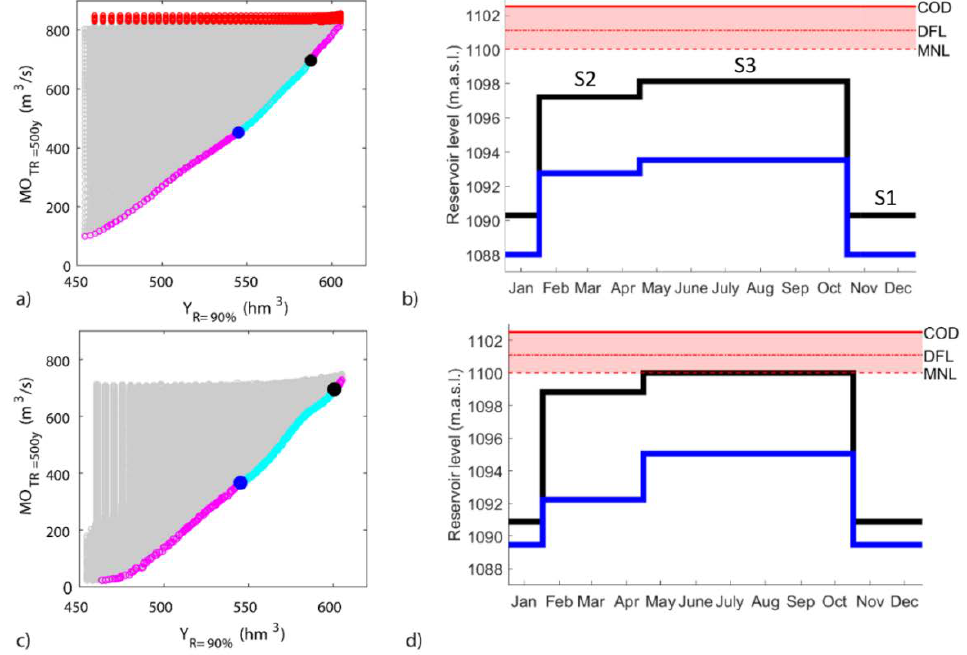
Figure 6. ( a , c ) Grey dots represent pair of values Y R = 90% and MO TR = 500y for Sc. 1 and Sc.2, respectively. Red dots ( a ) represent the configurations in which MWRL TR = 1000y > DFL. Magenta dots indicate the pareto front. Cyan dots represent the proposed solutions. The black dot represents the solution that maximizes the water volume supplied with a reliability of 90% and MO TR = 500y = O EMER . The blue dot represents the solution that minimizes the maximum outflow released (being Y R = 90% = Da). ( b , d ) MCLs for each month / season which corresponds to the proposed solutions previously selected (blue and black lines correspond to blue and black dots in ( a ) and ( c )), for Sc.1 and Sc.2, respectively. The red dashed line represents the maximum normal level (MNL), the red dashed–dotted line represents the design flood level (DFL), and the red continuous line represents the crest of dam (COD).